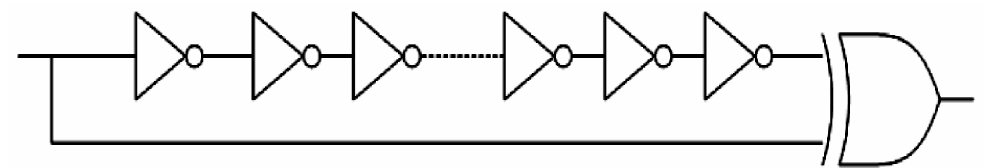
Figure 12. Diagram of a phase locked loop